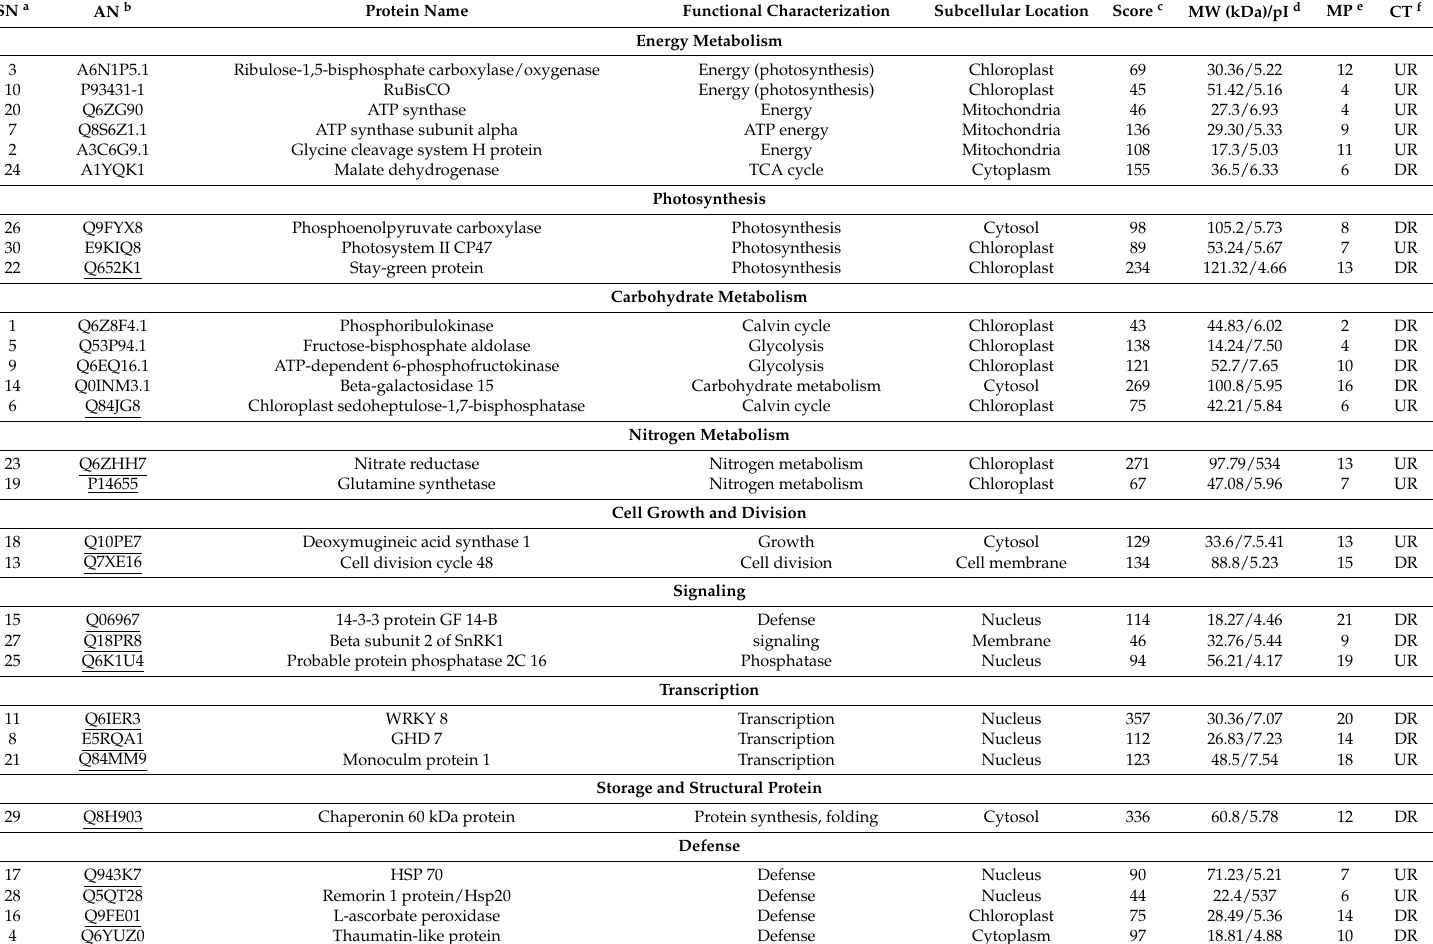
Table 1. Differential expression of leaf proteins between WT and PP2C9TL at 10 DAF under low N